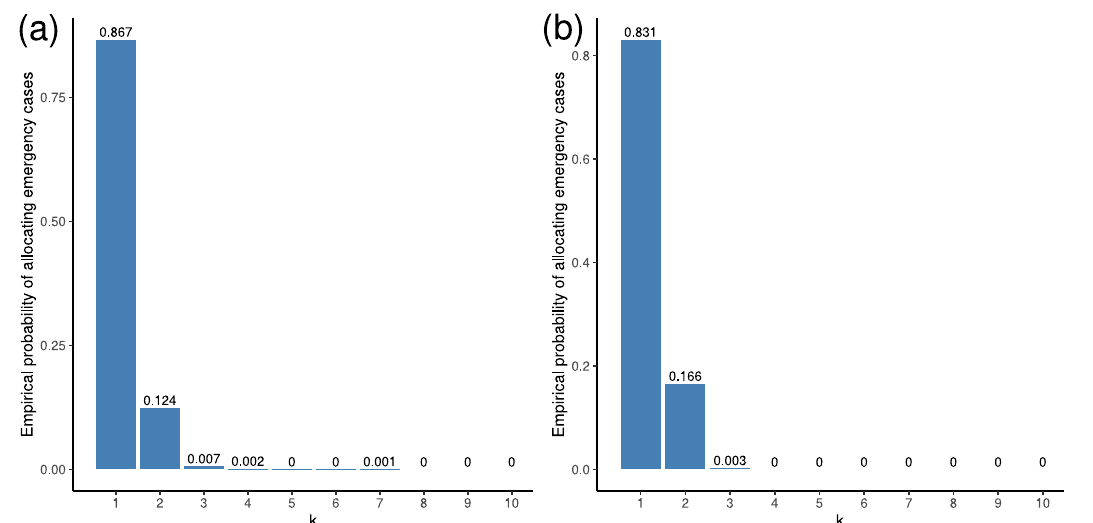
Figure 9. The empirical probabilities of emergency cases to be allocated to the k-th closest hospitals. ( a ) We used the Euclidean distances. ( b ) We used the road network distances. In the analyses only "sphs" and "sps" trips were